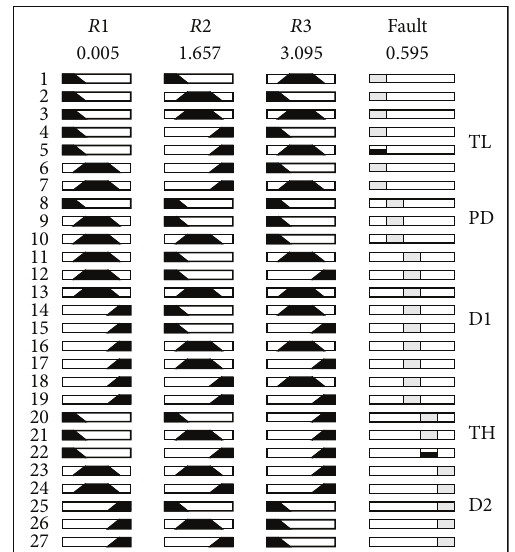
Figure 4: Rule viewer for